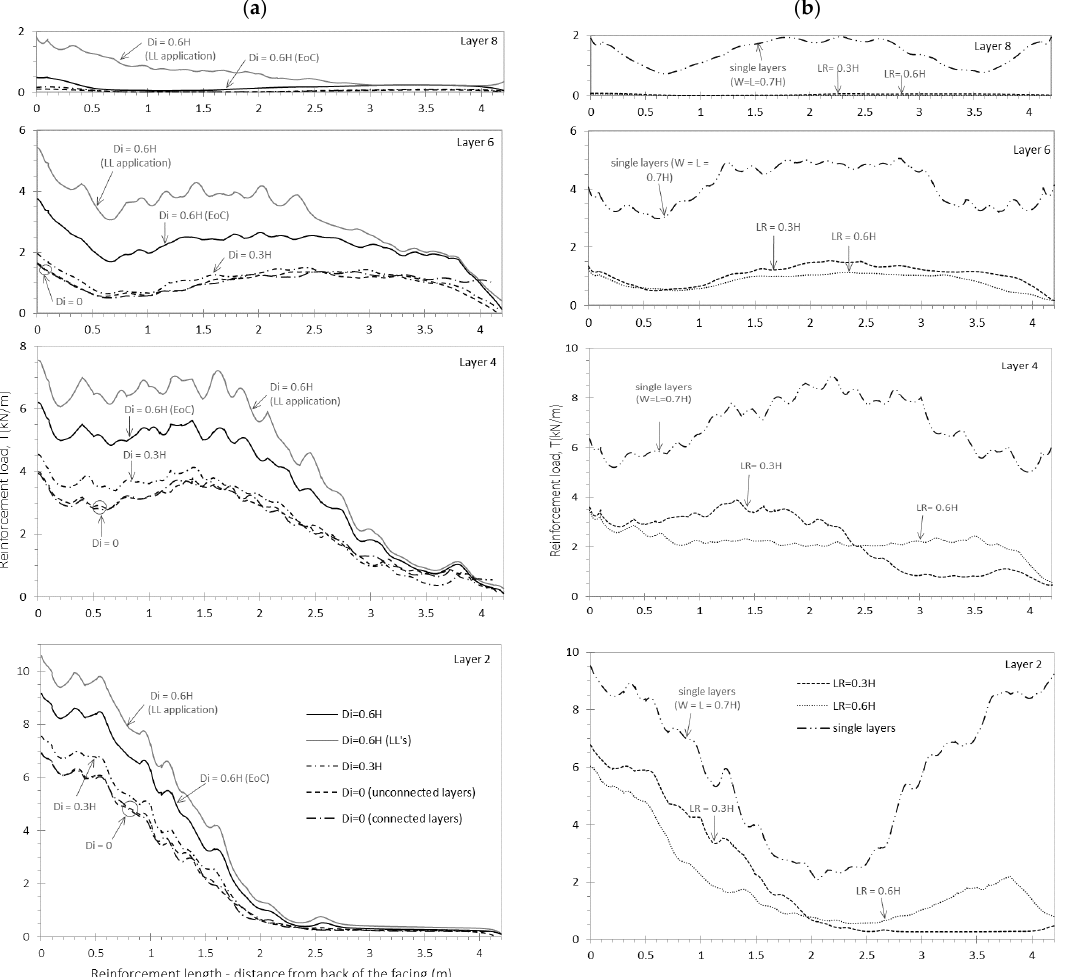
Figure 16. Reinforcement loads at end of construction (EoC) for walls with different interaction distances ( D i ) between the back of the reinforced soil zones for opposite walls: ( a ) D i > 0 and D i = 0, and ( b ) D i <